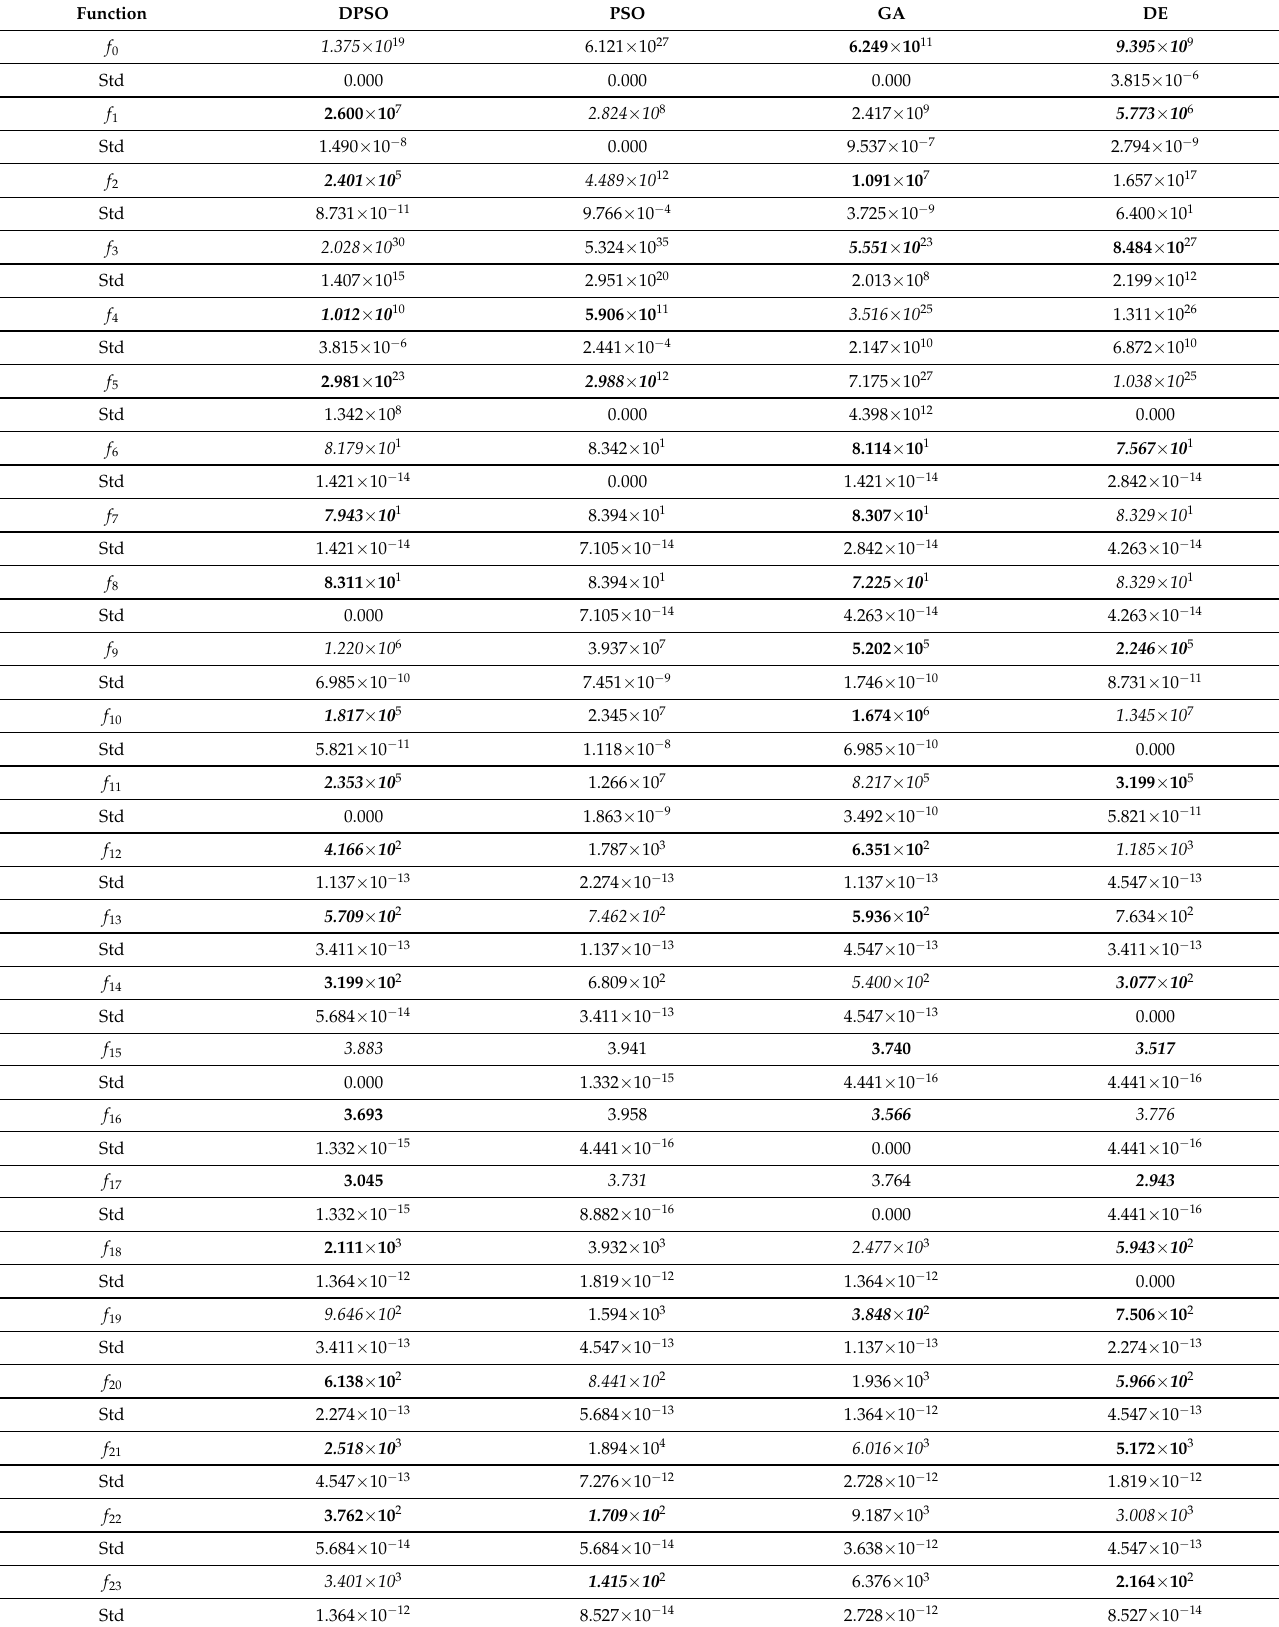
Table A6. Fitness w.r.t. each function problem with 21 dimensions and the resulting ranking: rank 1 (best) , rank 2 , rank 3 , and rank